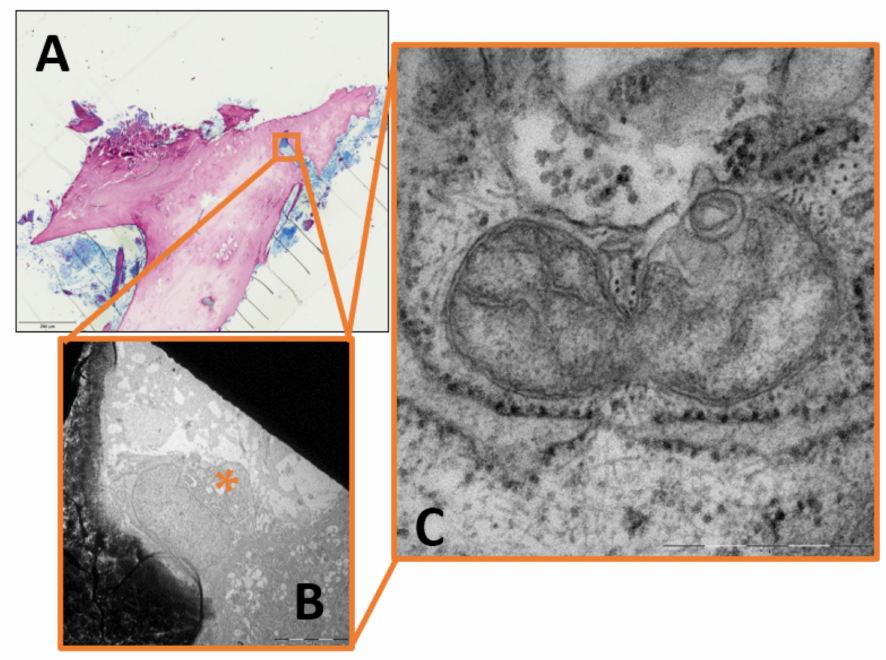
Figure 1. ( A ) Light microscopy image of infectious bone (magnification × 40). ( B ) Magnification of ( A ). Transmission electron microscopy image of osteoblast next to osteoclast. Fission site indicated by star (magnification × 5000). ( C ) Magnification of ( B ). Mitochondrion in midst of fission that is being pinched by endoplasmic reticulum (magnification × 40,000).